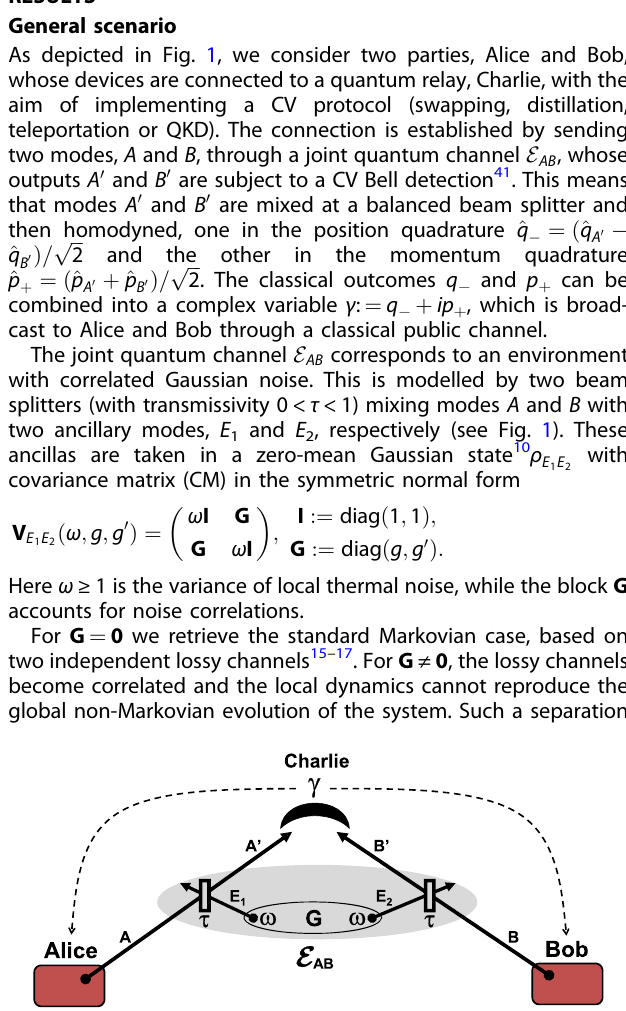
Fig. 1 Quantum relay. Alice and Bob connect their devices (red boxes) to a quantum relay, Charlie, for implementing a CV protocol. On the received modes, Charlie always performs a CV Bell detection whose outcome γ is broadcast. Separable Gaussian environment . The travelling modes are subject to a joint Gaussian channel E AB . This is realized by two beam splitters with tranmissivity τ which mix A and B with two ancillary modes, E 1 and E 2 , respectively. These ancillas Fig. 2 Non-Markovian reactivation of 1 × 3 quadripartite entan- inject thermal noise with variance ω and belong to a correlated (but glement. Assuming maximally entangled states for the parties and . Entanglement breaking . For ω > ω EB ( τ ), separable) Gaussian state ρ E entanglement-breaking conditions (here τ = 0.9 and ω = 1.02 × ω EB 1 E 2 = 19.38), we show how quadripartite entanglement is reactivated by bipartite (and tripartite) entanglement cannot survive at the relay. In particular, A 0 is disentangled from Alice ’ s device, and B 0 is increasing the separable correlations of the environment (bits of disentangled from Bob ’ s, no matter if the environment is correlated quantum mutual information, which are constant over the or not. Non-Markovian reactivation . Above a critical amount of concentric contour lines). Inside the grey region there is no separable correlations, quadripartite entanglement is reactivated quadripartite entanglement with respect to any 1 × 3 grouping of between Alice ’ s and Bob ’ s devices and the transmitted modes, A 0 the four modes abA 0 B 0 . Outside the grey region all the possible 1 × 3 and B 0 . Bell detection can localize this multipartite resource into a groupings are entangled. The external black region is excluded, as it bipartite form and reactivate all the protocols. corresponds to entangled or unphysical